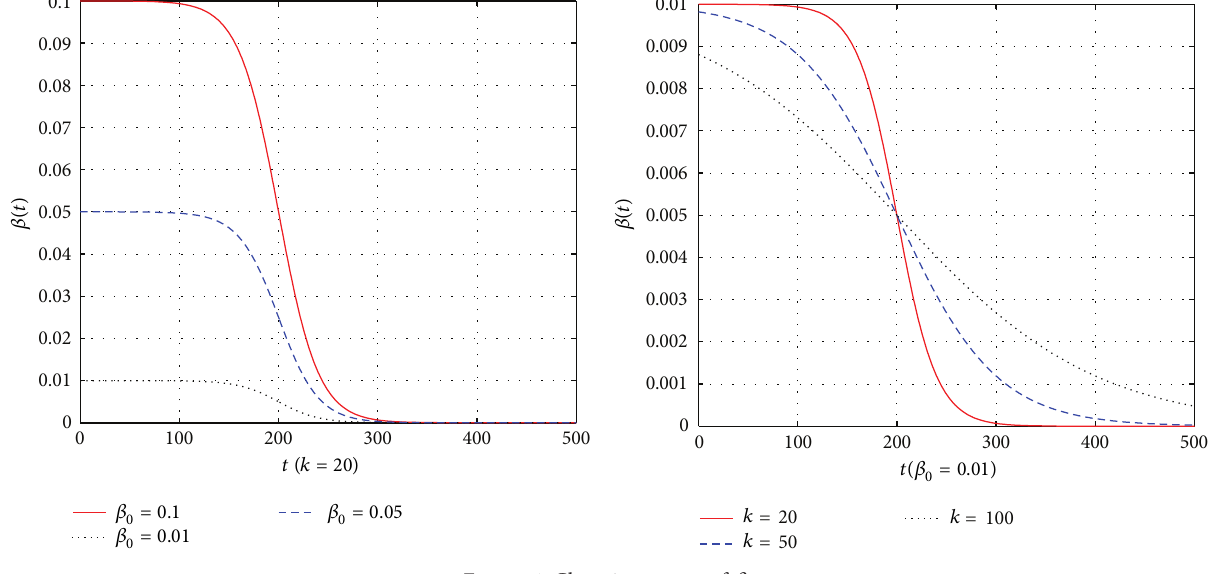
Figure 1: Changing curves of 𝛽